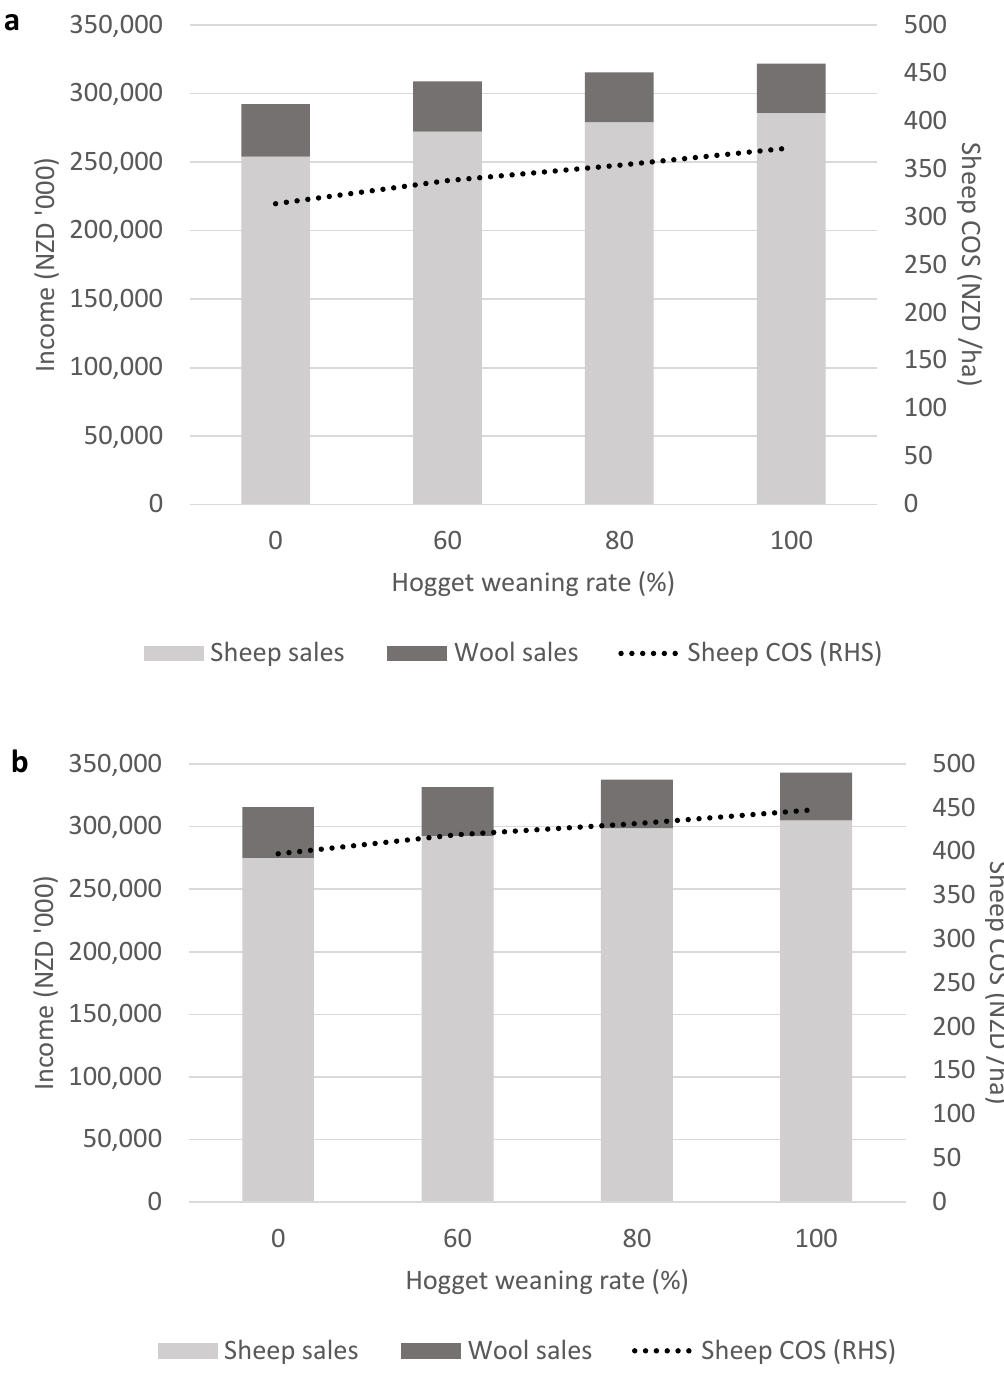
Figure 5. Sheep enterprise income from sheep and wool sales and sheep enterprise cash operating surplus (COS) with varying hogget weaning rates and with mature ewe weaning rates of ( a ) 132% and ( b ) 150%.